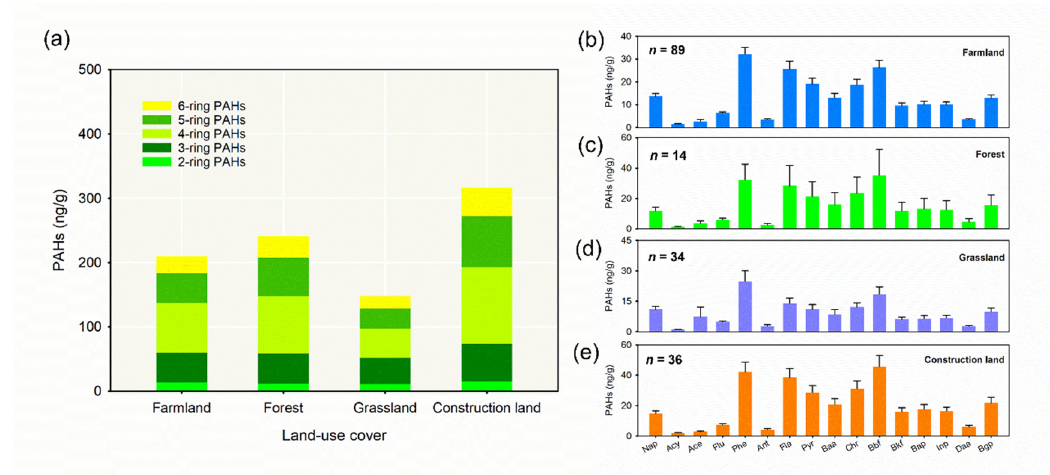
Figure 6. Stacked histogram of PAHs with different ring numbers ( a ) and histogram of 16 individual PAHs ( b – e ) under different land-use covers in Shanxi Province.